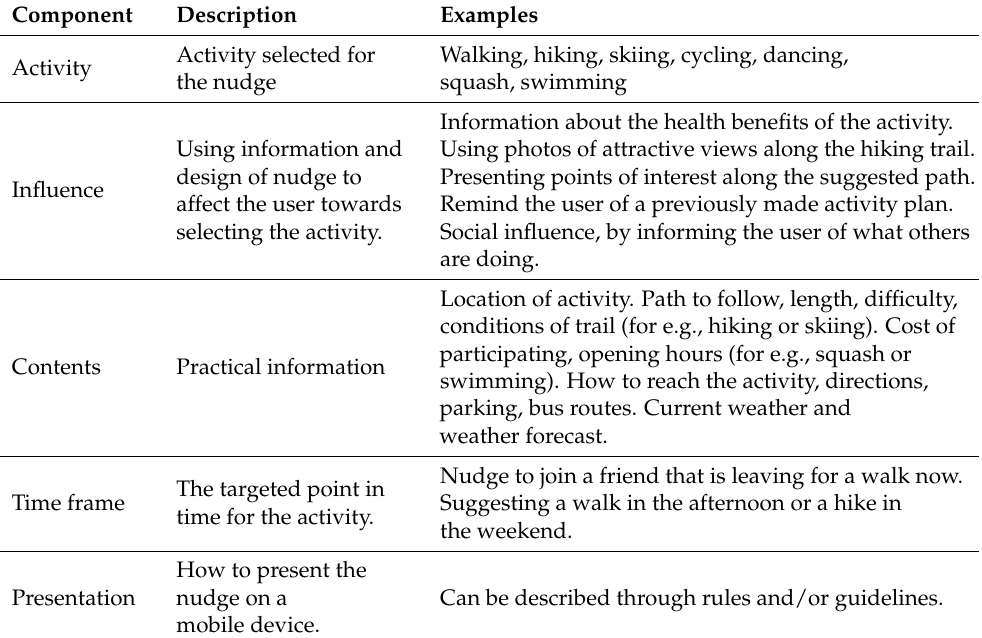
Table 1. Examples of nudge components supporting the nudging goal of “physical